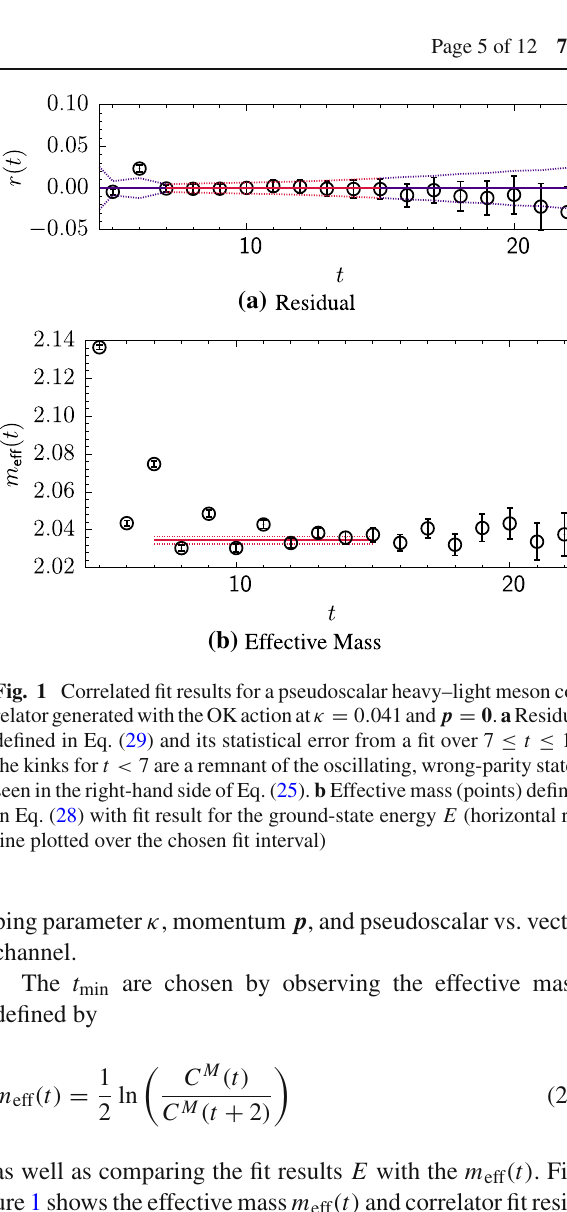
ping parameter κ , momentum p , and pseudoscalar vs. vector